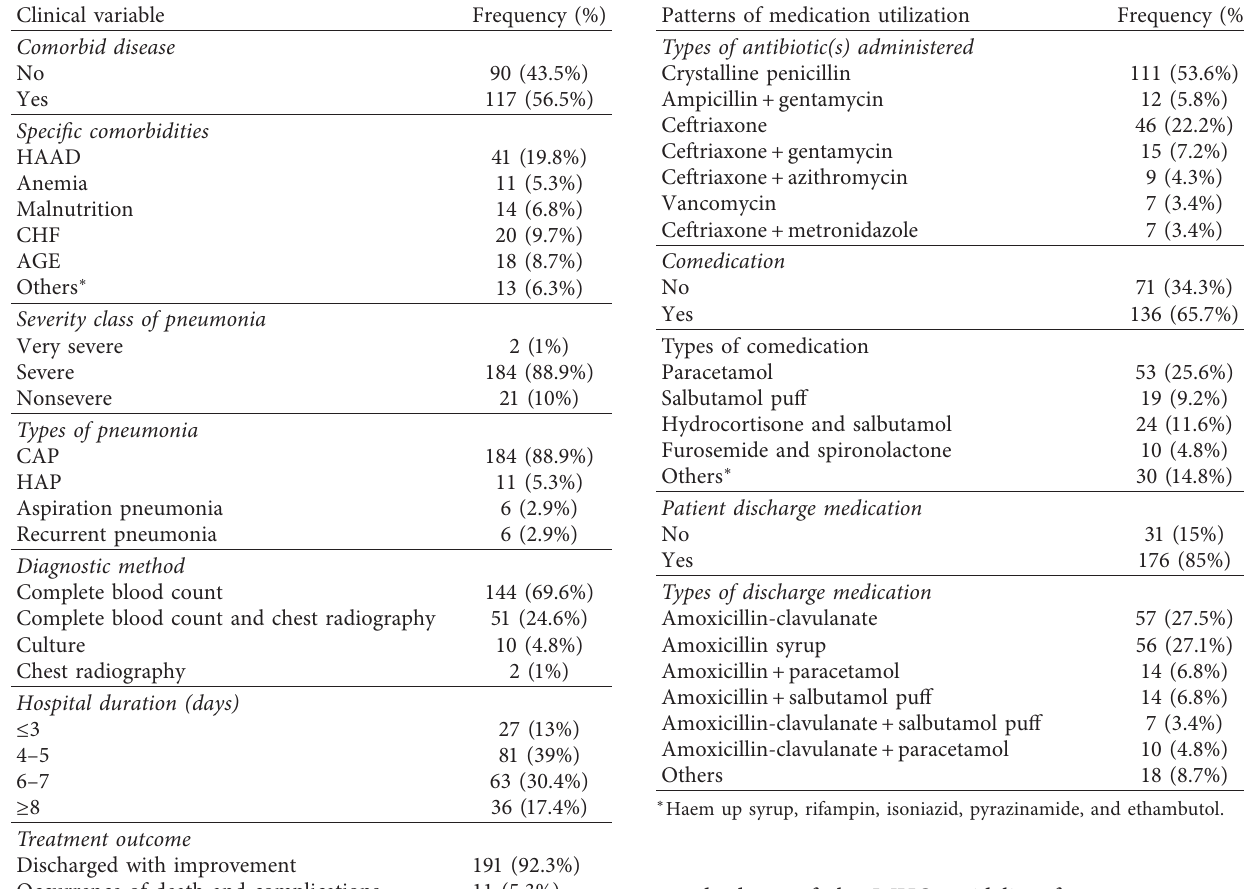
Table 3: Patterns of medication utilization among children treated for pneumonia at the pediatric ward of Tikur Anbessa Specialized Hospital from February 2017 to February 2018, Addis Ababa, Ethiopia.